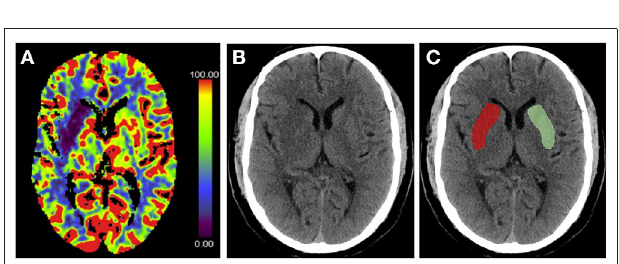
FIGURE 3 | Measurement of % net water uptake (NWU) per volume on admission. (A) The initial ischemic core is identified by the initial relative cerebral blood flow (CBF) volume using a threshold of < 30% in CBF maps. (B) Non-enhanced computed tomography shows a slight decrease in the density of the right basal ganglia region. (C) The mean density of the initial core (D ischemic ) (red) was calculated in relation to the normal density (D normal ) (green) in the homotopic contralateral region. NWU = 1 – D Ischemic /D Normal